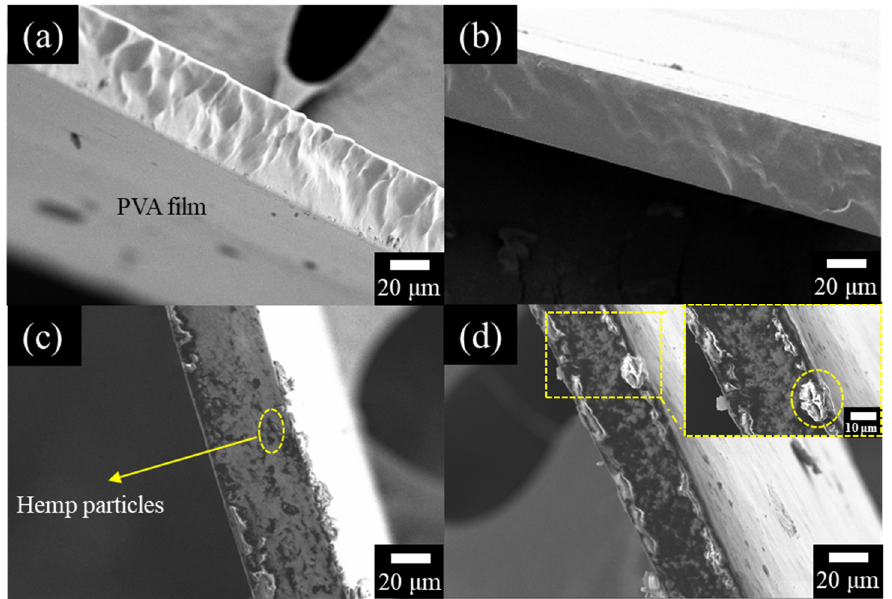
Figure 4. The cross-section images of hemp/ polyvinyl alcohol (PVA) composite films with different hemp particle weight ratios: ( a ) 0%, ( b ) 1%, ( c ) 5%, ( d ) 10%.